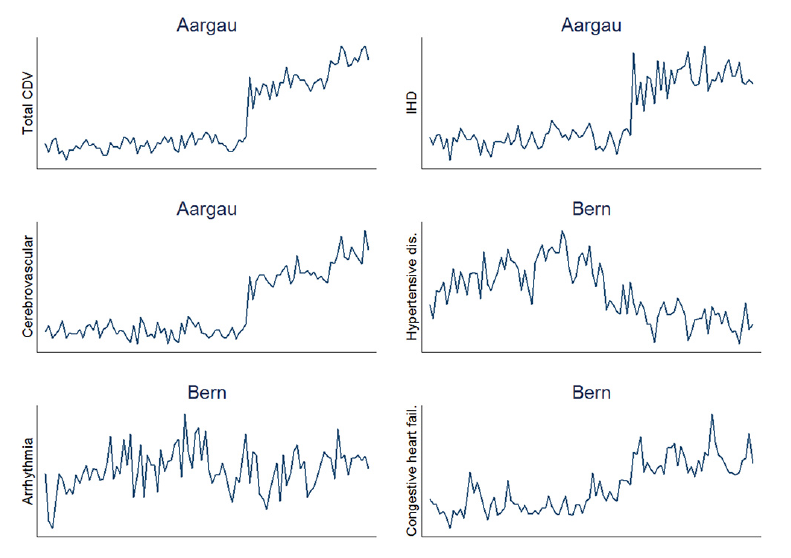
Figure S2 Time-series plots of the monthly counts (2005–2012) of the outcomes excluded from the metaregression analysis for Bern and Aargau. CDV = cardiovascular disease; IHD = ischaemic heart